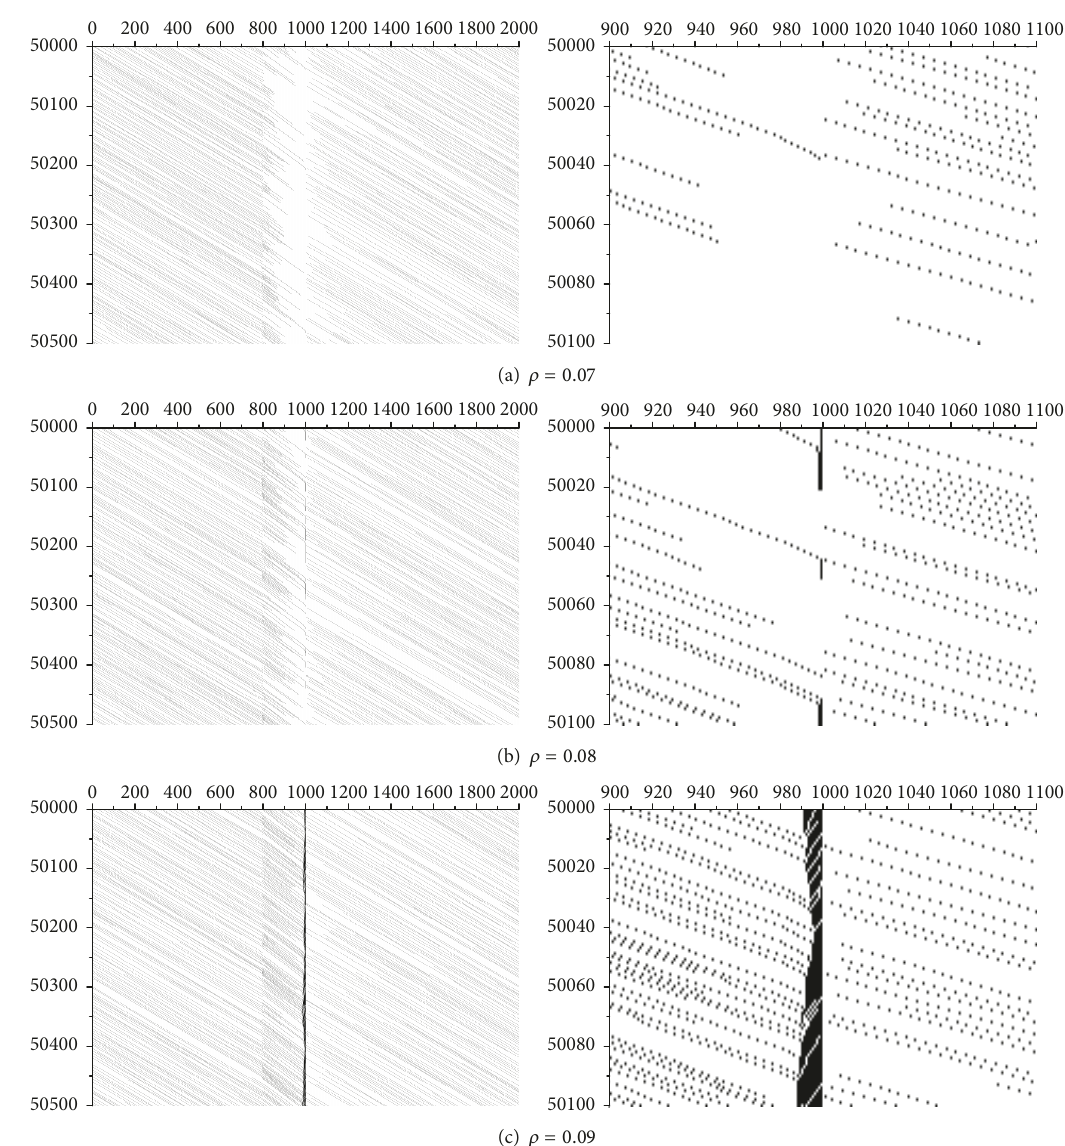
Figure 7: Spatiotemporal diagrams of the right lane in